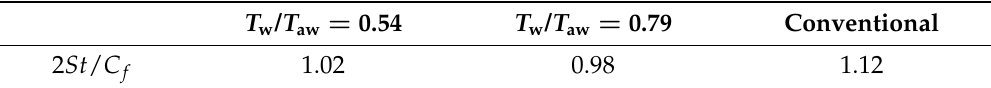
Table 5. Effect of wall temperature on Reynolds Analogy Factor (2 St / C f